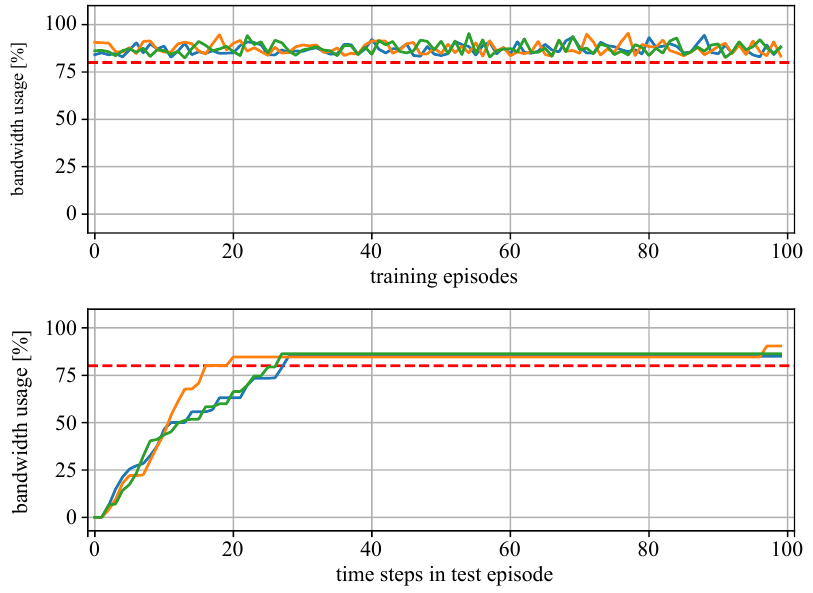
Figure 11. Results of the training and test of MAS2 with three agents (green, blue, orange lines: bandwidth usage; red dotted line: threshold 80%). Above: Bandwidth usage at the end of each training episode. Below: Bandwidth usage at each time step of a single test episode.